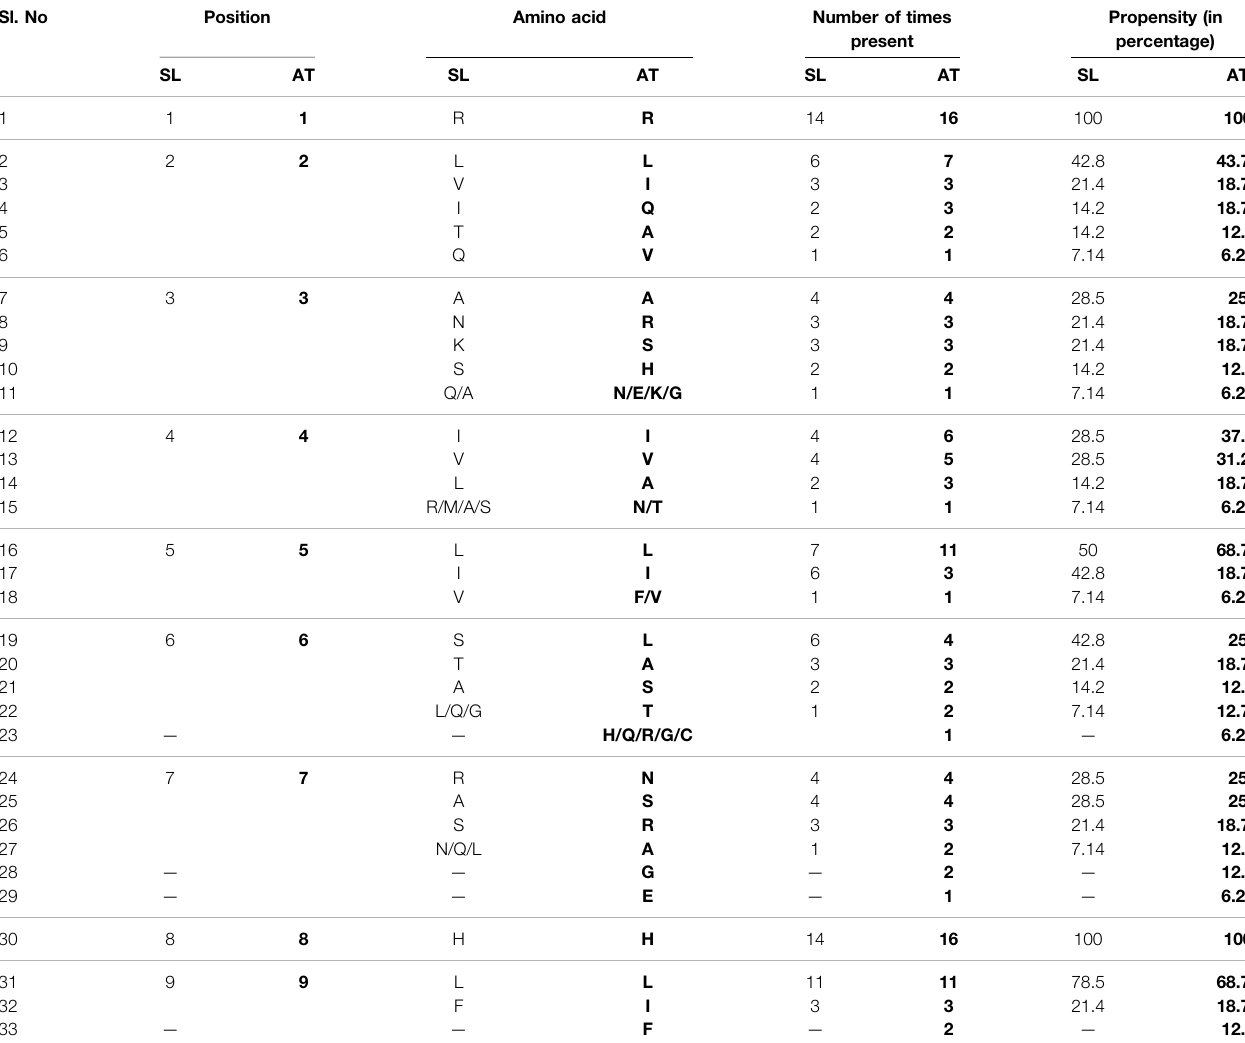
TABLE 1| Aminoacidpropensity at variouspositionsofPTS2in Arabidopsisthaliana and Solanumlycopersicum :PTS2sequences fromboth theplantspeciesweremined from the database and the speci fi c amino acids present at various positions were listed. Sl.